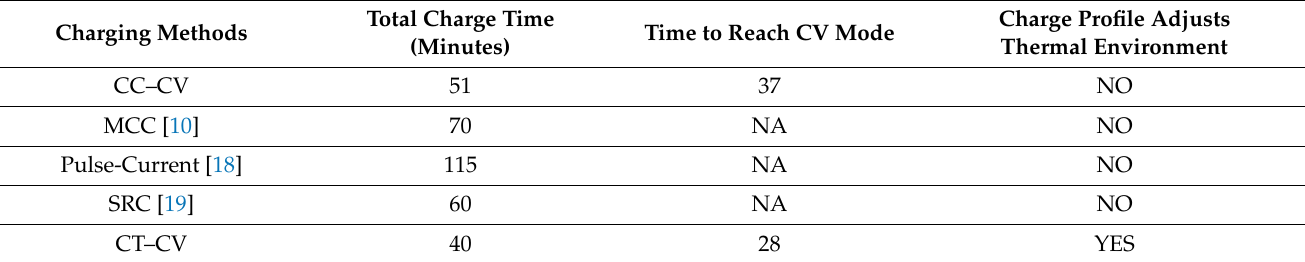
Table 3. Comparison of various charging